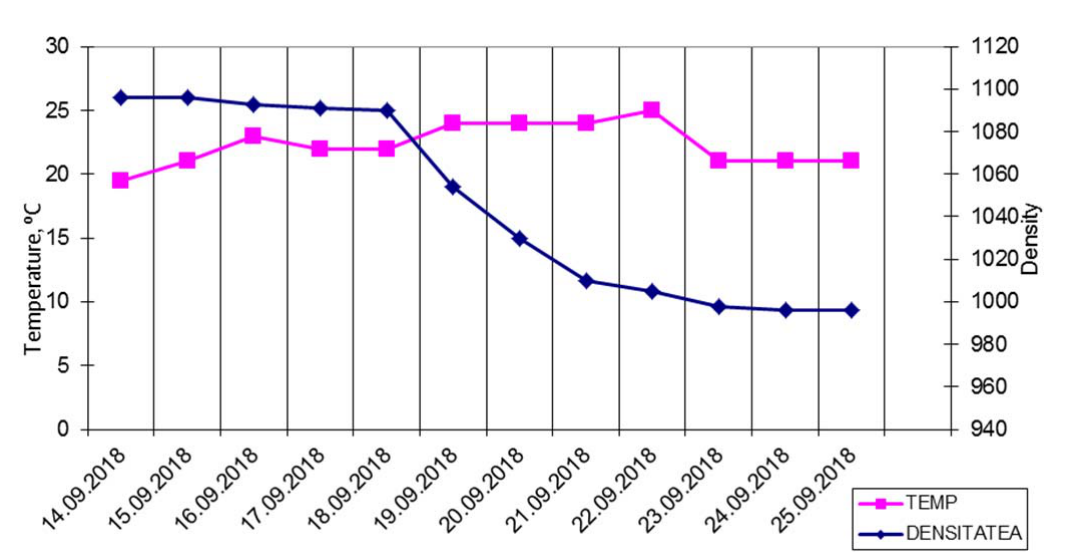
Figure 3. Dynamics of the process of alcoholic fermentation of Feteasca Neagr ă grape mush in microwinery conditions (harvest year 2018).